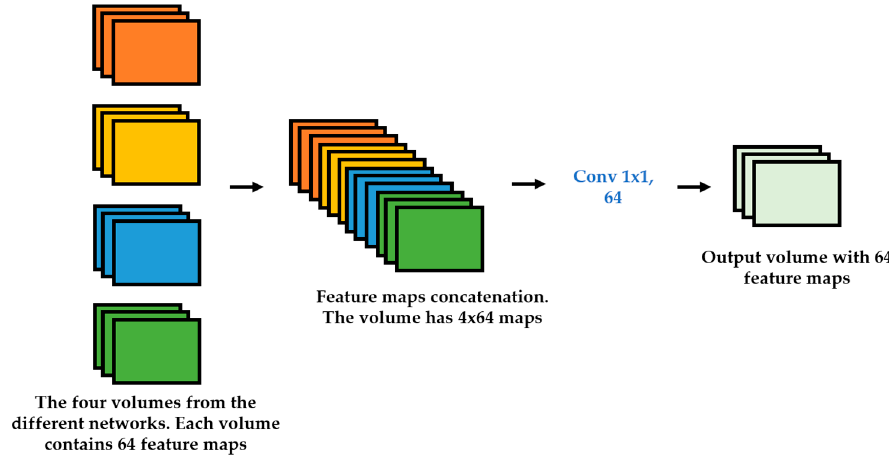
Figure 7. Illustration of the summation layer’s structure.